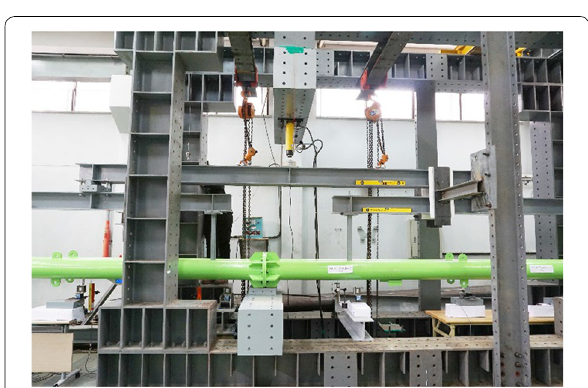
Fig. 4 Test of cable wall system.